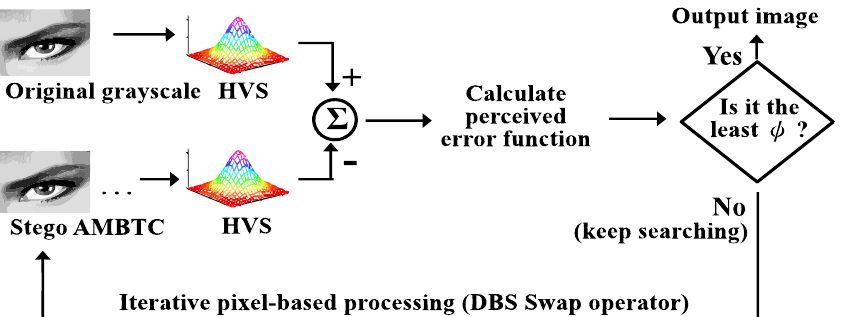
Figure 4. Concept of the DBS optimization framework used in this study.